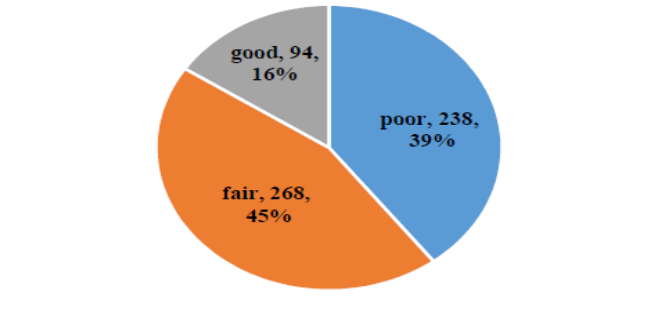
Figure 3: shows the distribution of studied sample according to physical health. The higher number of parents reported fair physical health.